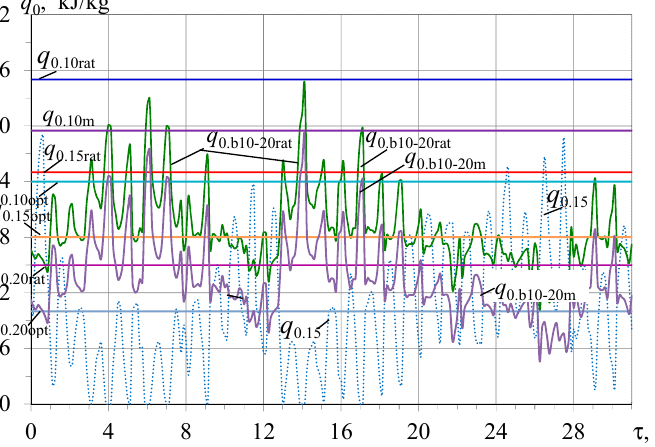
Figure 8. Current available specific boost cooling capacities q 0.b10-20rat and q 0.b10-20m for cooling ambient air to t a 2 = 20 °C: q 0.b10-20rat = q 0.10rat − q 0.10-20 ; q 0.b10-20m = q 0.10m − q 0.10-20 ; q 0.10m = ( q 0.10rat + q 0.10opt )/2; q 0.10-20 = q 0.10 − q 0.20 .